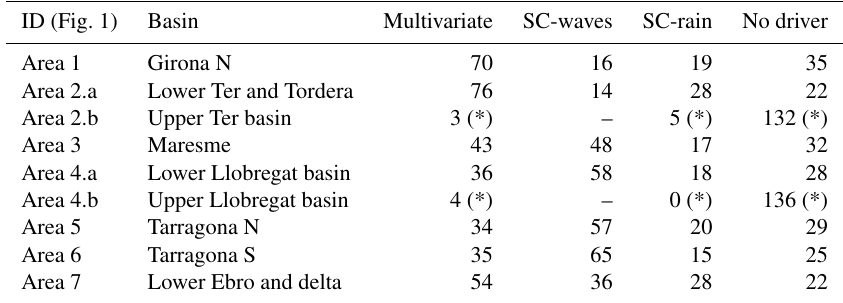
Table 2. Number of compound events per type of occurrence of climatic drivers at each basin.